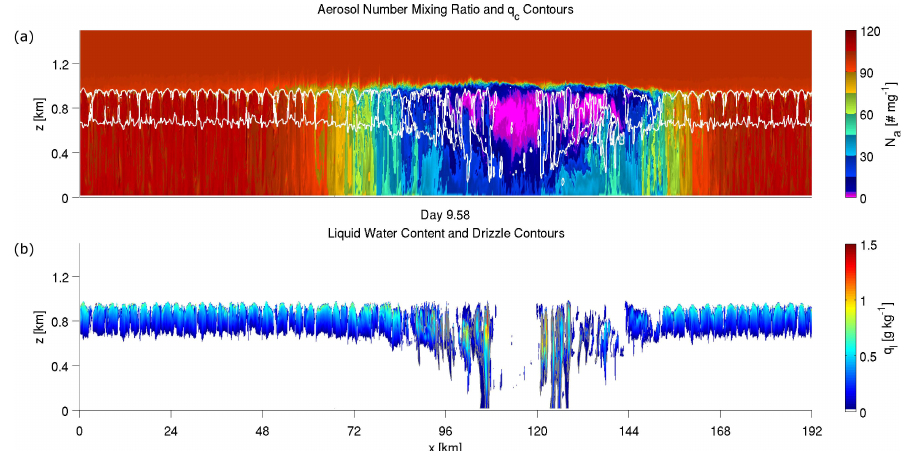
Fig. 16. x – z sections from W5/NA100:50-POC on day 9.58. Panels as in Fig. 12.